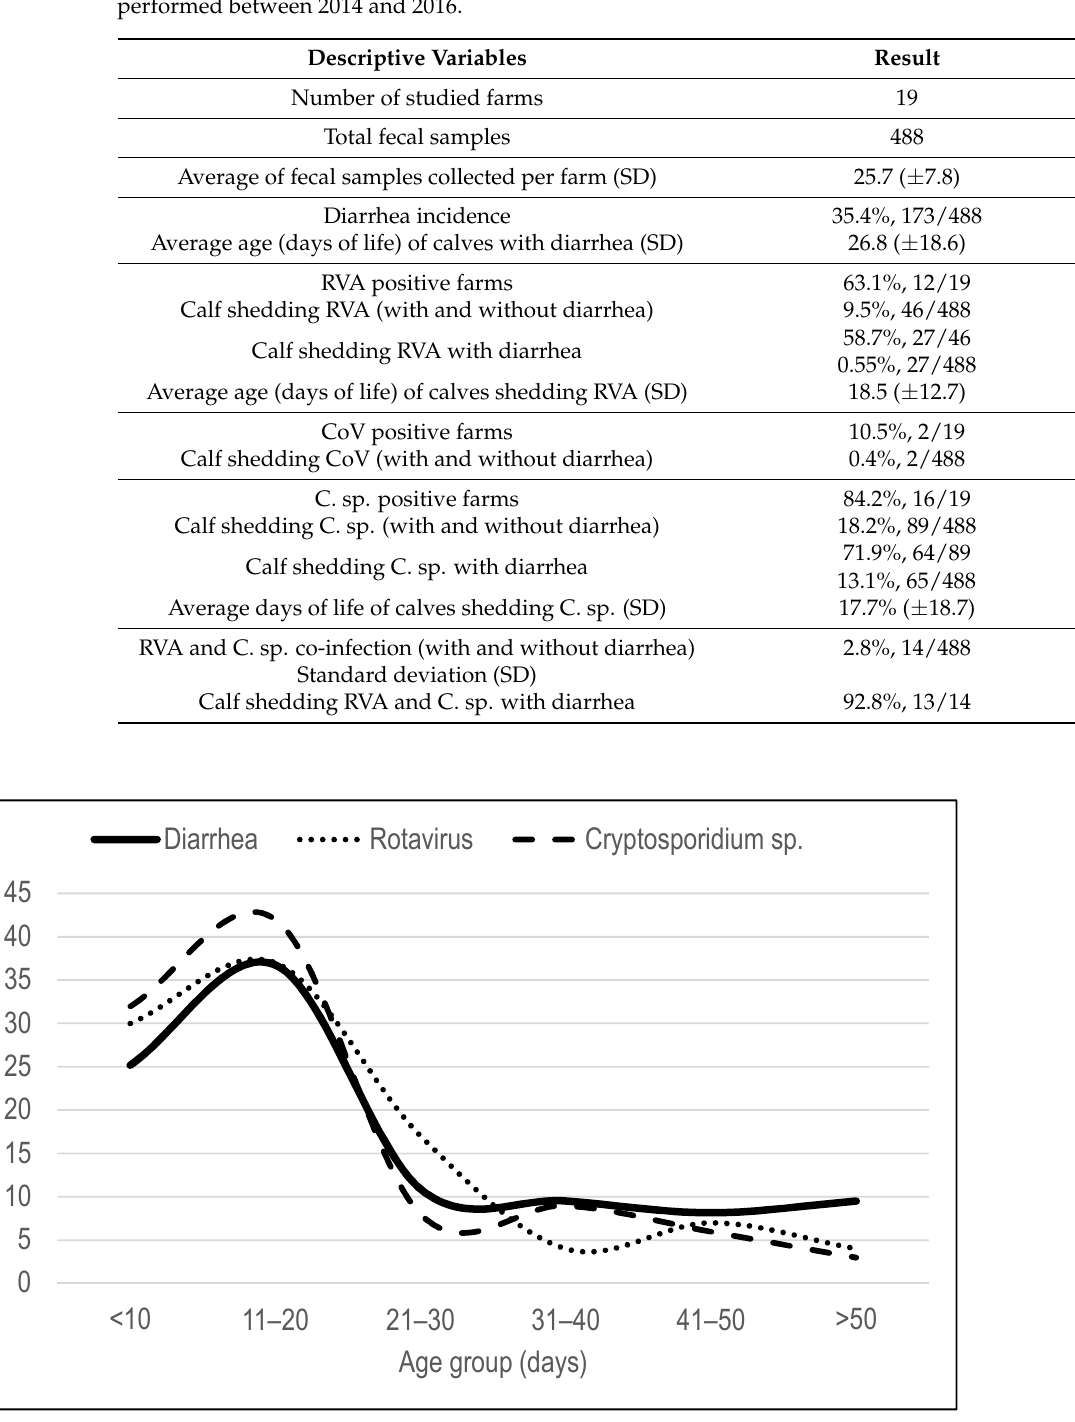
Figure 1. Incidence of scours, rotavirus, and Cryptosporidium sp. infections in the different age groups of dairy calves. As can be observed in the Figure 1, both RVA and C. sp. infections were associated with diarrhea in calves younger than 20 days of age.